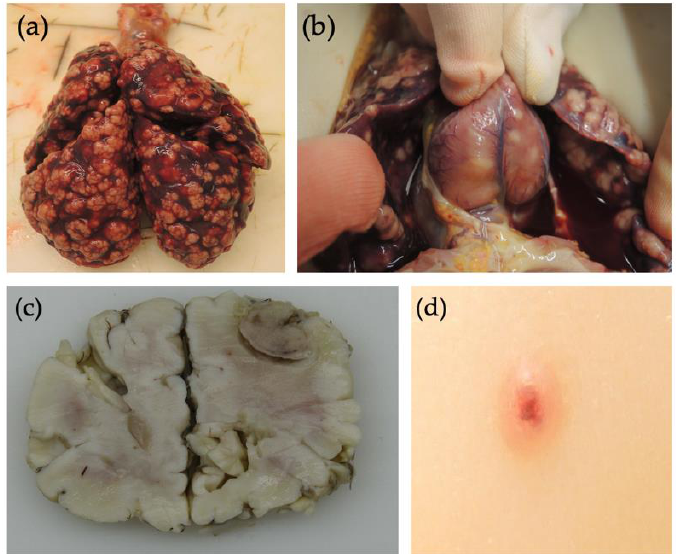
Figure 3. Autopsy of the neonate revealed numerous nodules in the ( a ) lung parenchyma, ( b ) myocardium, and ( c ) leptomeninges. ( d ) Bluish, papular nodule on the trunk of neonate representing myofibroma affecting the skin.